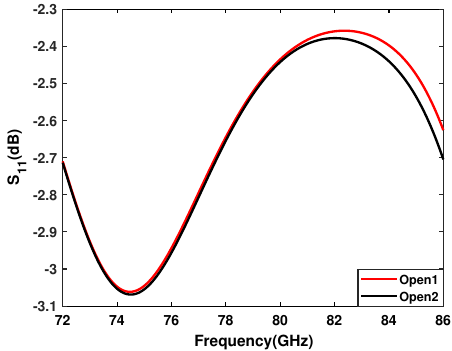
Figure 18. S 11 of the designed open